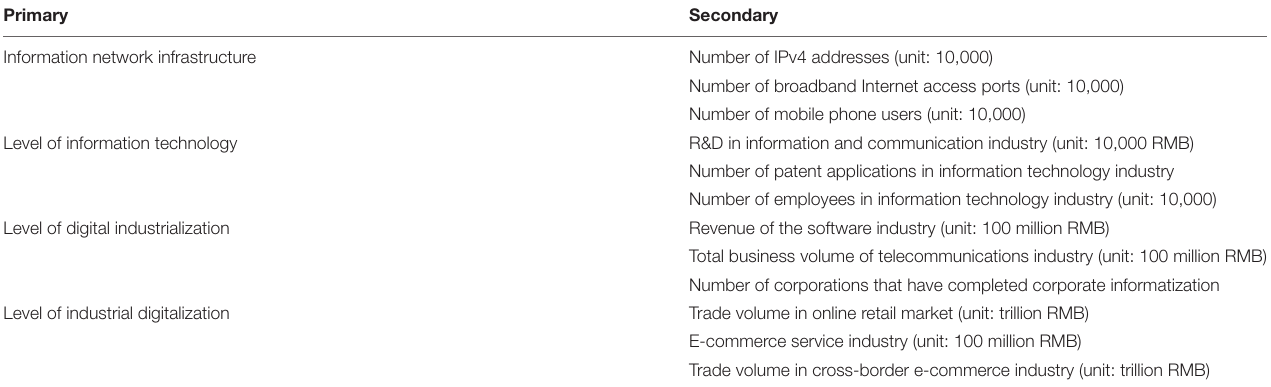
TABLE 3 | Indices for digital trade development